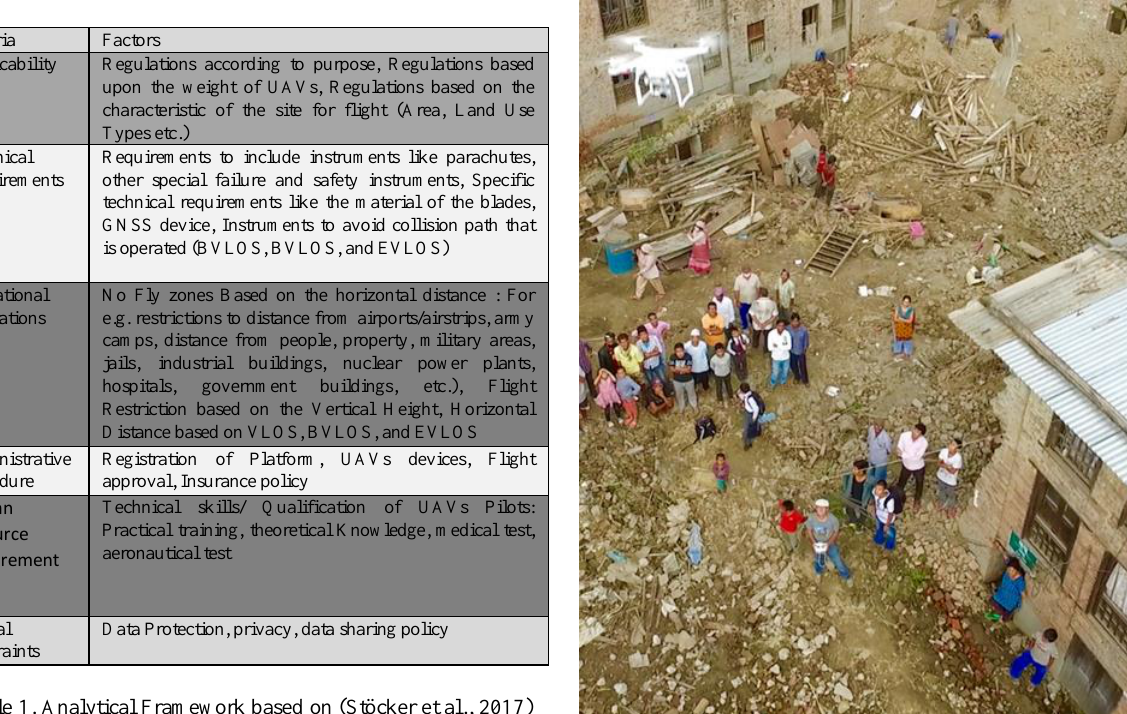
Table 1. Analytical Framework based on (Stöcker et al., 2017) and modified by authors Figure 1. UAV flight to capture Aerial image of Panga